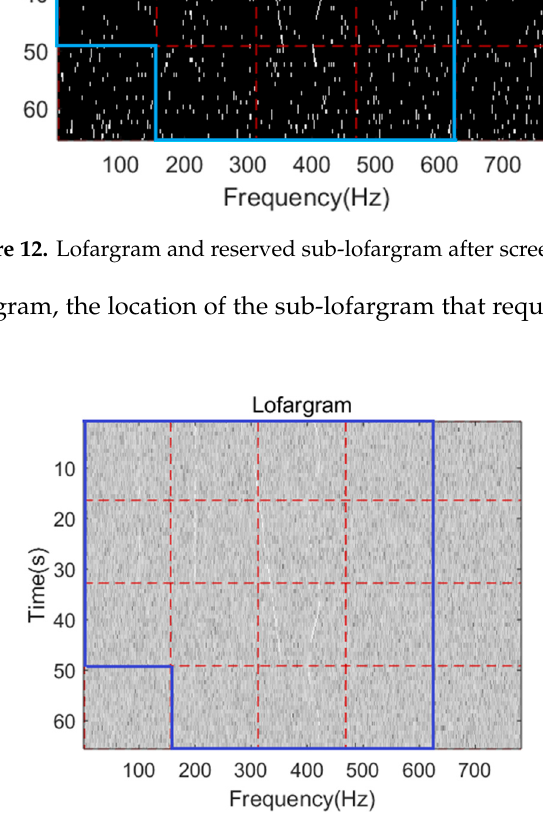
Figure 12. Lofargram and reserved sub-lofargram after screening.